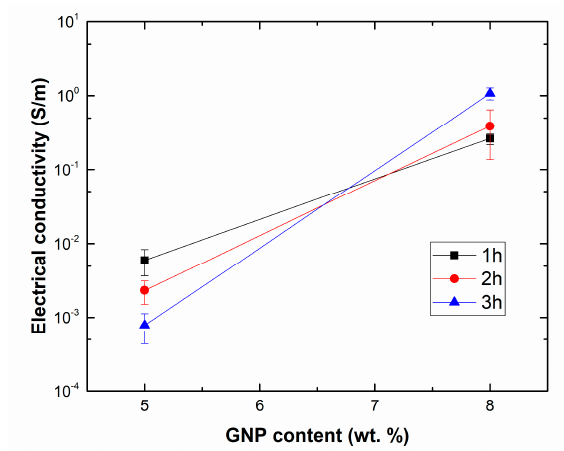
Figure 2. Electrical conductivity measurements for the different samples.